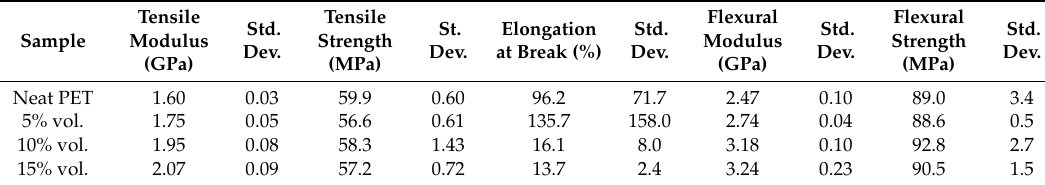
Table 6. Tensile properties of amorphous PET amorphous PET and Al 1 / amorphous PET composites. Std. Dev. is the standard deviation.